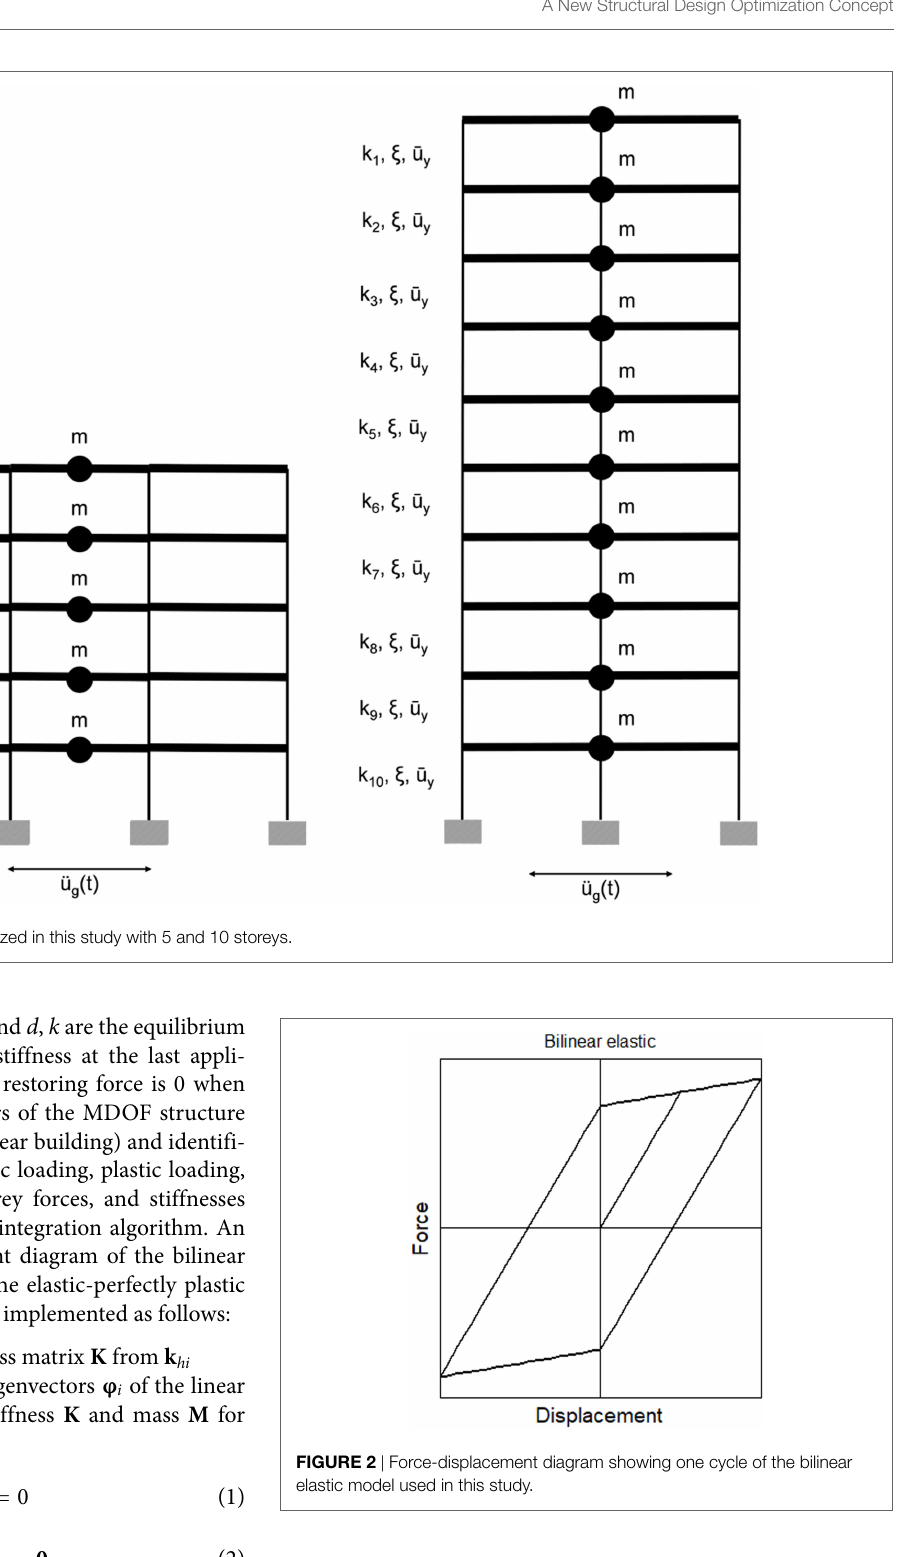
(cid:15) ( (cid:3)(cid:3) )Read the values of u , _ u and add a zero element to u , _ u to account for the fixed